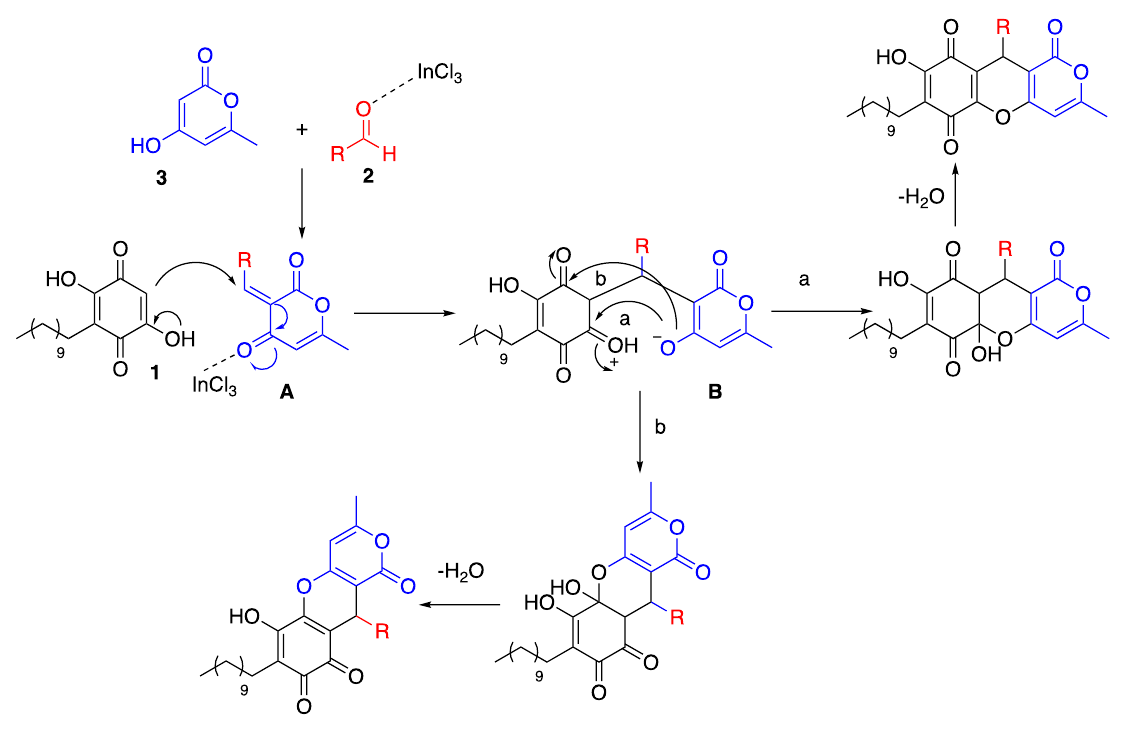
Table 3. Synthesis of novel embelin – coumarin conjugates ( 4a – 4l